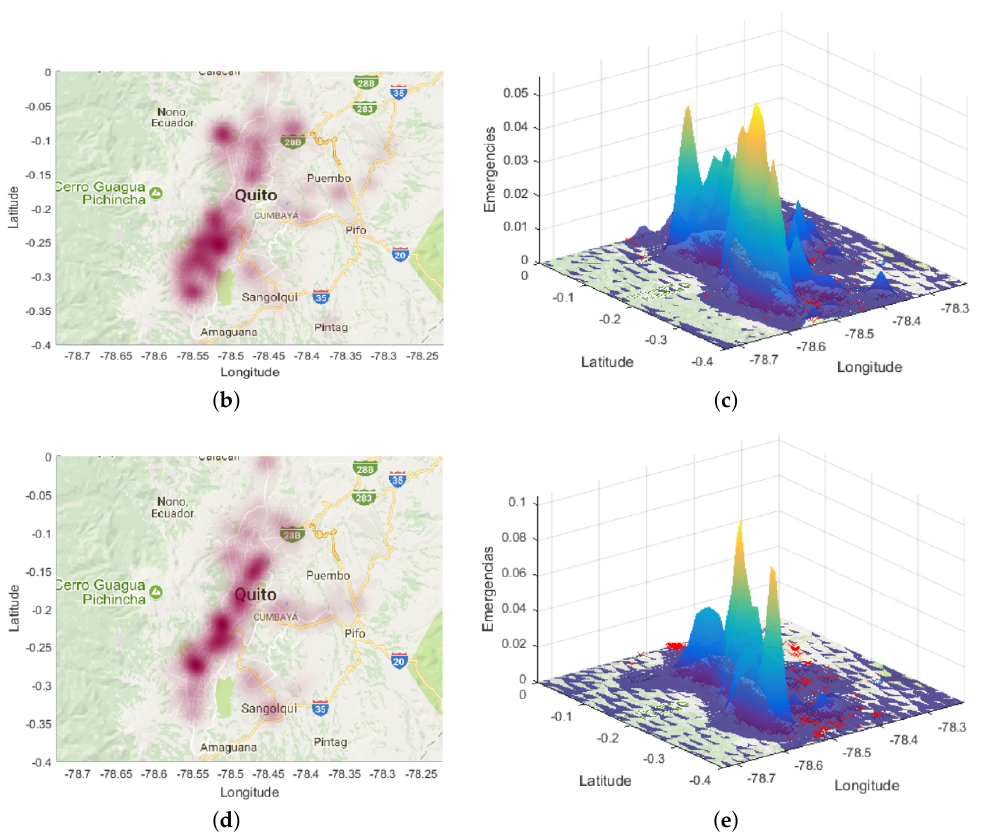
Figure 11. Analysis of health emergencies. ( a ) Events during 2014, with maximum and minimum peaks; ( b , c ) Parzen distribution in red gradient over the map and bidimensional probability density function (PDF) representation for maximum peak on 1 January; ( d , e ) The same for minimum peak on 6 August.